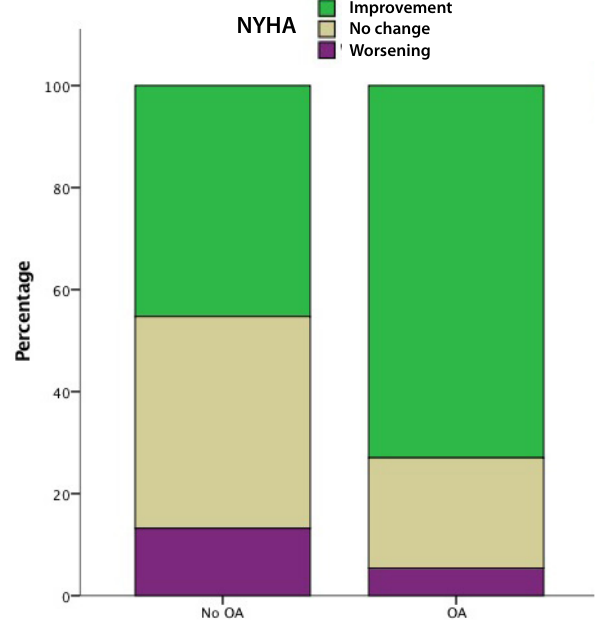
Fig. 1 – Change in New York Heart Association (NYHA) class at follow-up in patients with and without oral anticoagulation (OA). Green=patients who improved their NYHA; brown=patients who reported no change in their NYHA; purple=patients who